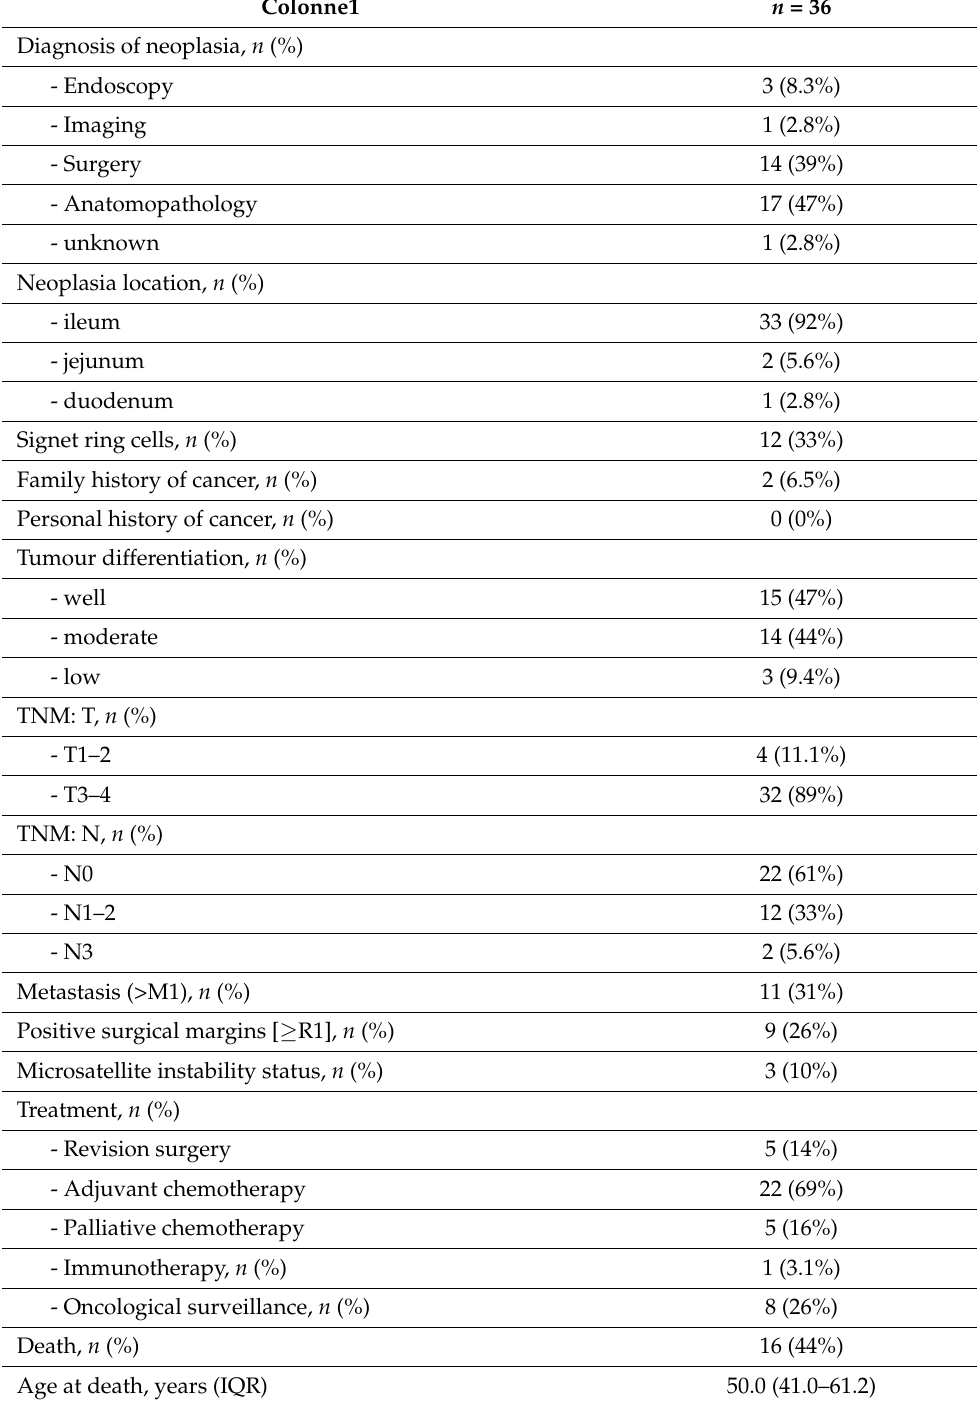
Table 6. Oncological details, management, and outcomes in the adenocarcinoma